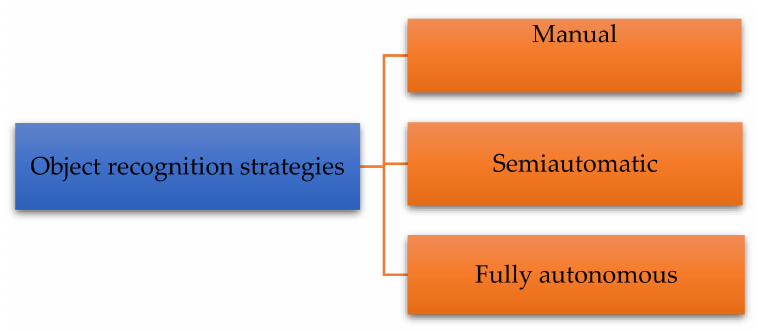
Figure 1. Object recognition